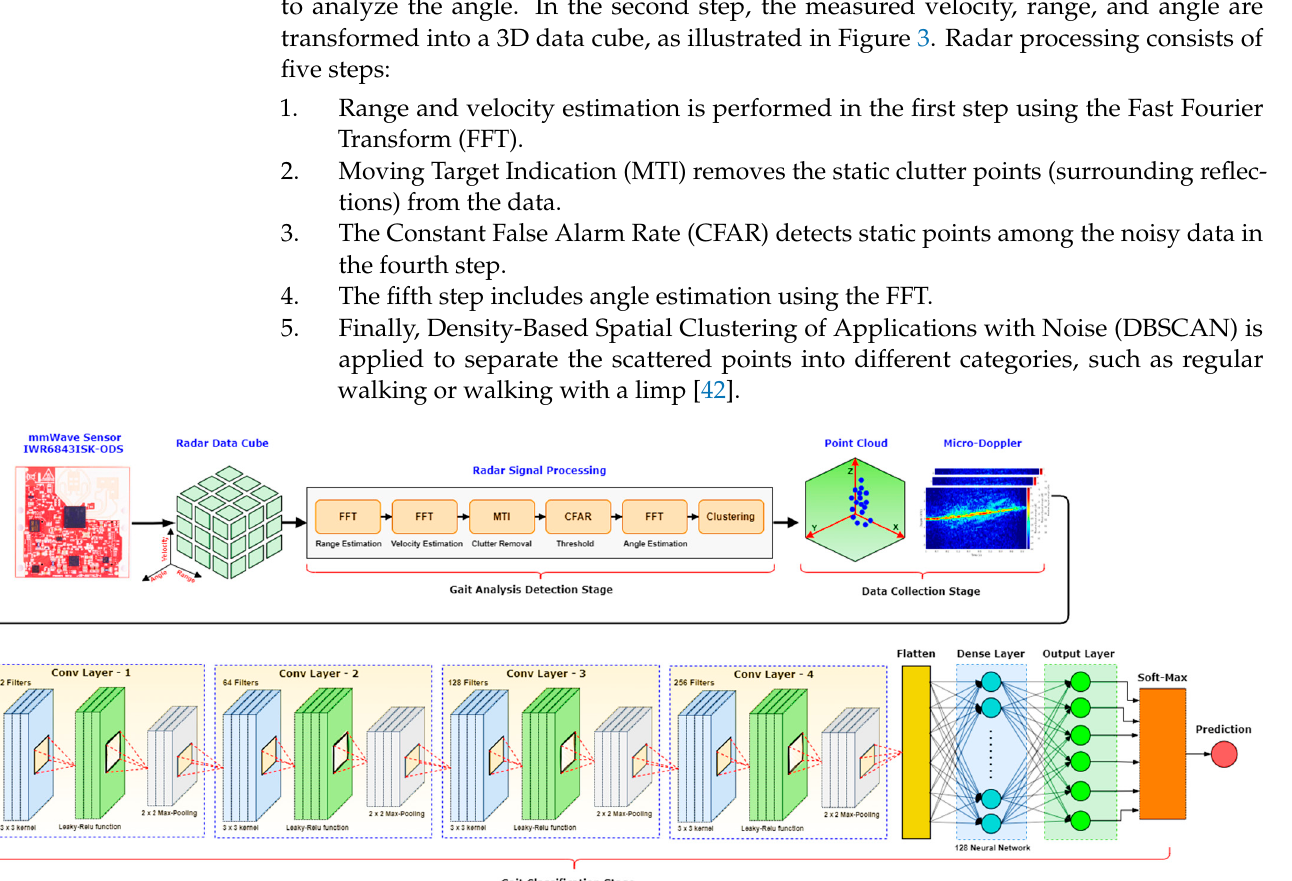
Figure 4. Micro-Doppler signature of different activities. The last step of this approach is to distinguish five different activities based on the micro-Doppler signature of each activity. For that, we use a four-layered CNN, as illus- trated in Figure 3, due to its high accuracy and low loss rate. We experimented with mul- tiple CNN layers during our analysis, and our results show that optimal results are achieved with four convolution layers. Figure 3 shows that each layer consists of a 3 × 3 kernel, with depths of 32, 64, 128, and 256, respectively. Further, we use the Leaky-Recti- fied Linear Activation Unit ( ReLU ) to mitigate the dying ReLU impact that sends a few neurons to the inactive state [43]. Next to ReLU , a 2D max-pooling layer reduces the com- putation complexity by downsampling the previous layer’s output while keeping the